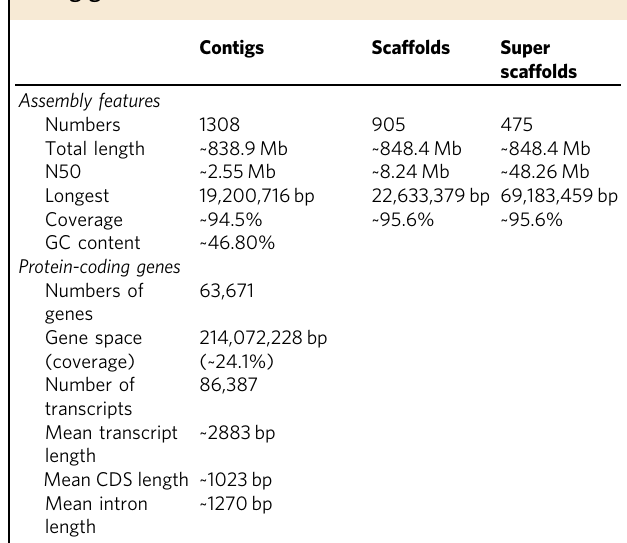
Table 1 The statistics of genome assembly and protein- coding genes in broomcorn